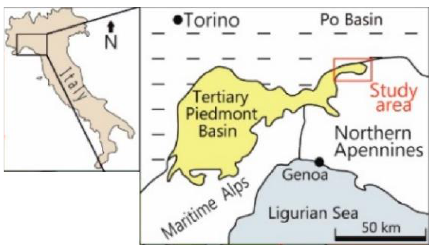
Figure 1. Location of the surveyed area; the red box indicates the position of the studied outcrop.